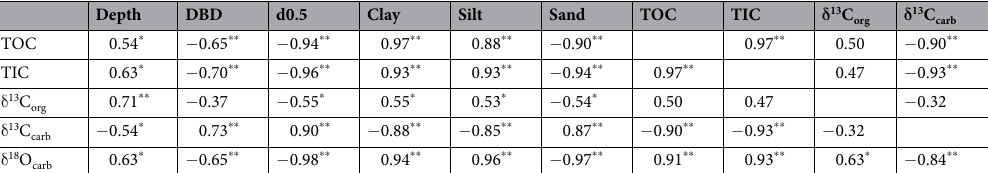
Table 4. Correlation coefficient (r) between various variables for the sediments. Significance of Pearson correlation is marked with one (p < 0.05) and two (p < 0.01)